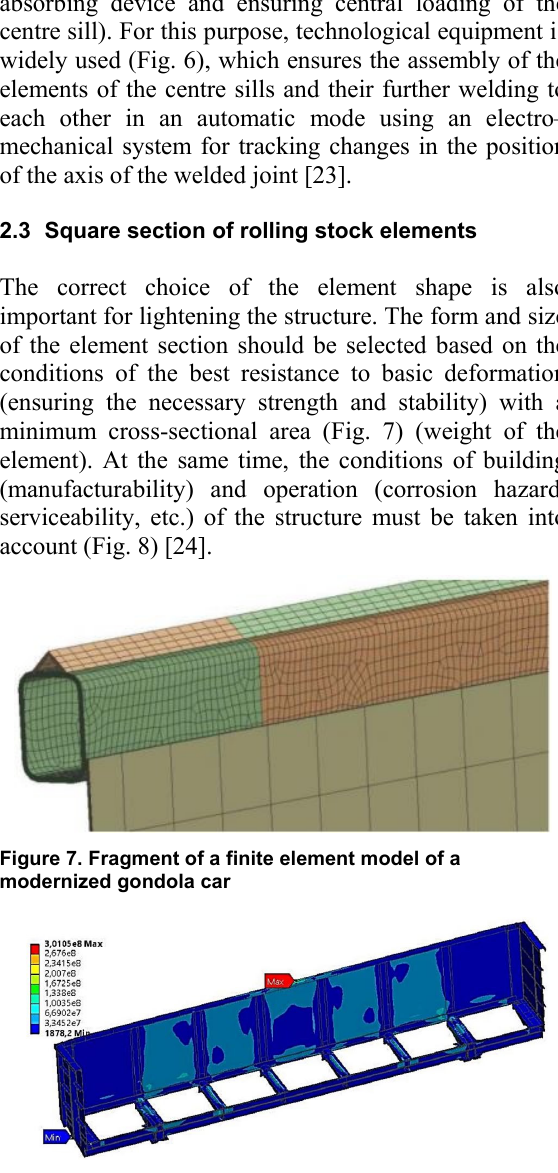
Figure 8. Stresses in the body of the modernized gondola